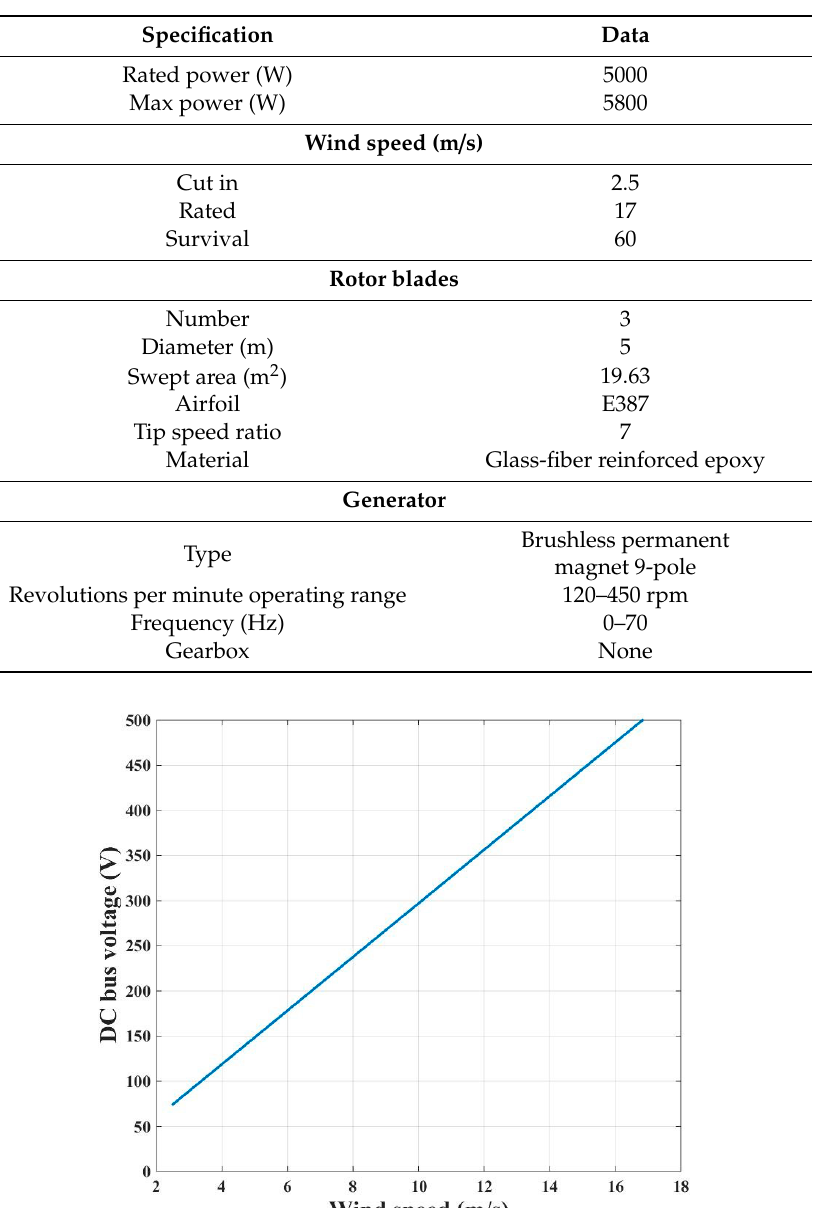
Table 1. Main parameters of the wind turbine [30].